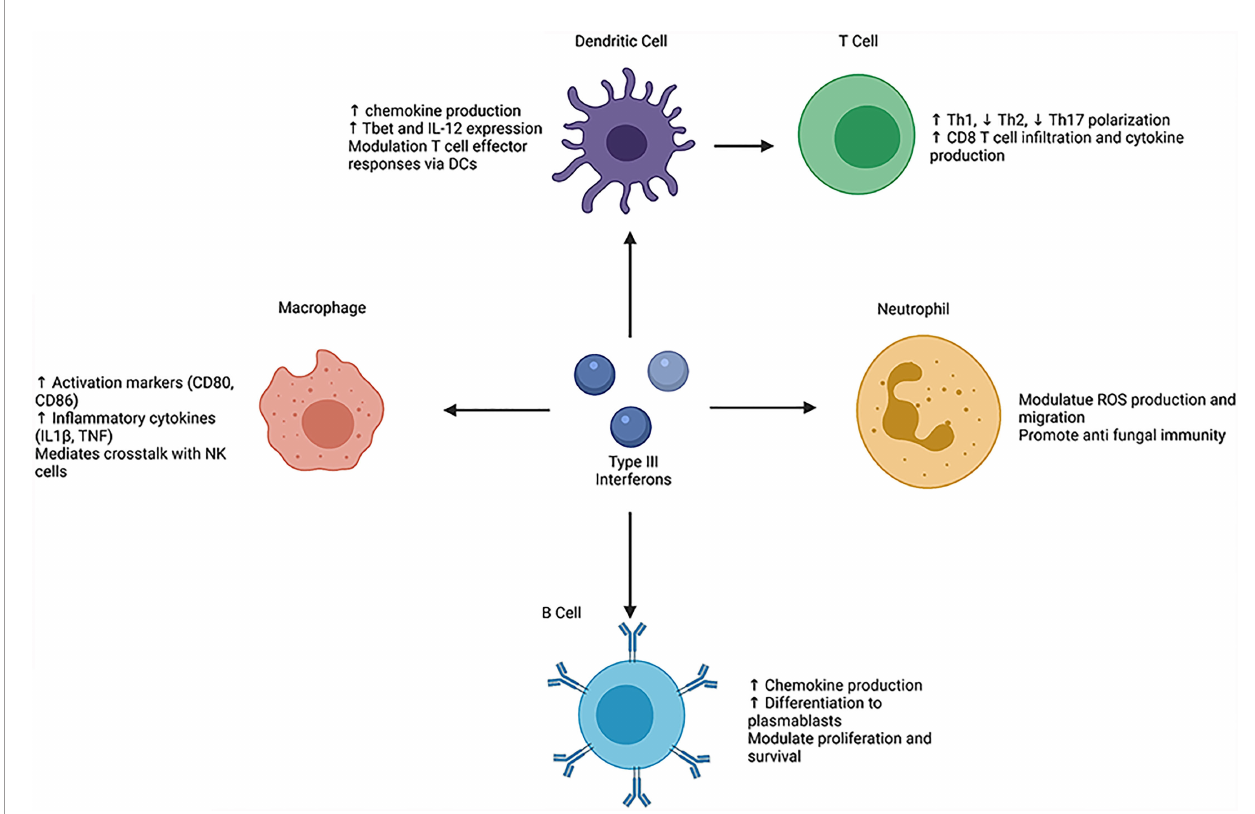
FIGURE 1 | Schematic overview of the direct and indirect effects of type III interferons on leukocyte phenotypes and functions. helper T cell (Th), T-box transcription factor (Tbet), interleukin (IL), tumor necrosis factor (TNF), natural killer (NK), reactive oxygen species (ROS). Created with